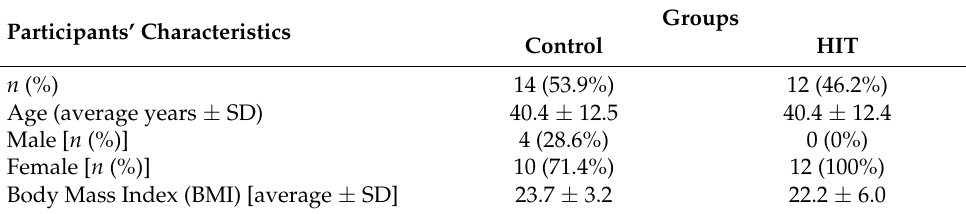
Table 1. Characteristics of the participants from the control and HIT